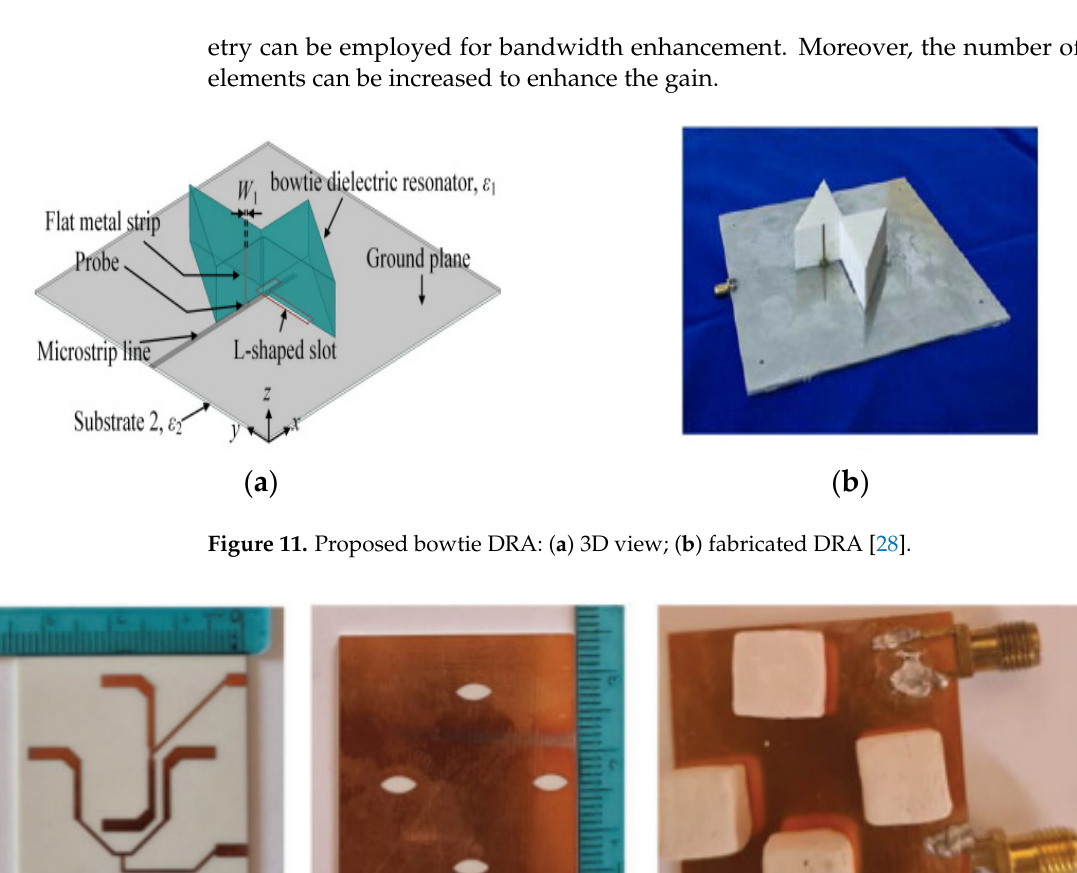
Figure 12. Fabricated RDRA array: ( a ) top plane; ( b ) bottom plane with eye slots; ( c ) bottom plane with dielectric resonators mounted over the eye slots [56].